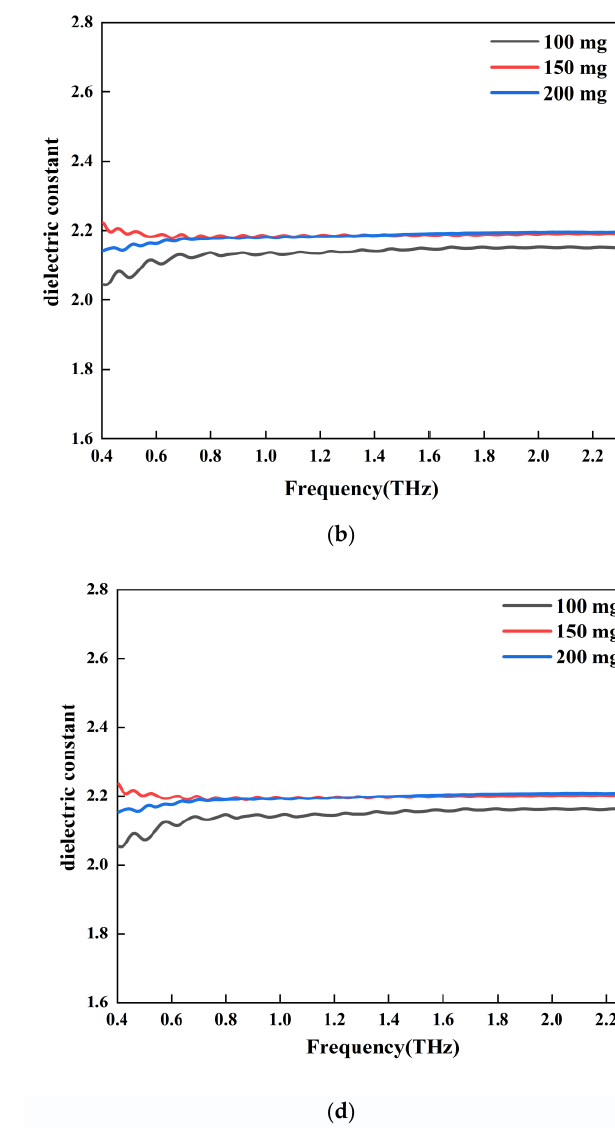
Figure 9. The PE dielectric spectrum obtained from the experimental test and the intrinsic dielectric spectrum processed by the model: ( a ) PE dielectric constant spectrum; ( b ) MG model PE intrinsic dielectric constant; ( c ) BM model PE intrinsic dielectric constant; ( d ) LLL model PE intrinsic dielectric constant.